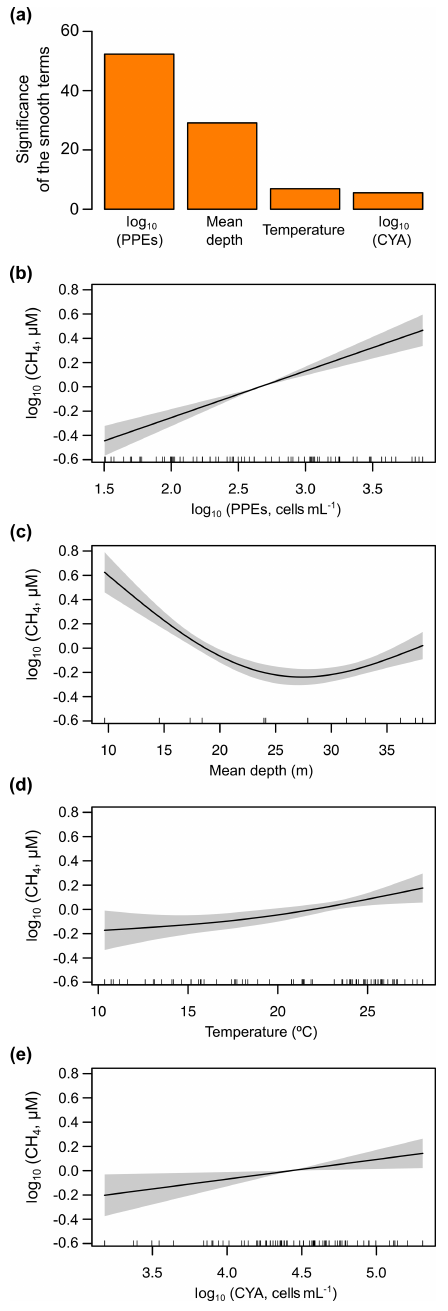
Figure 9. Results of the generalized additive model (GAM) fitted for the concentration of dissolved CH 4 in the oxic waters during the stratification period. (a) Bar plot showing the significance of the smooth terms from the fitted GAM ( F values). (b–e) Partial response plots from the fitted GAM, showing the additive effects of the covariates on the dissolved CH 4 concentration: the photo- synthetic picoeukaryotes’ abundance (log 10 PPEs) (b) , the mean depth (c) , the cyanobacteria abundance (log 10 CYA) (d) , and water temperature (e) . In partial response plots, the lines are the smooth- ing functions, and the shaded areas represent 95% pointwise confi- dence intervals. Rugs on x axis indicate the distribution of the data. More details are provided in Table